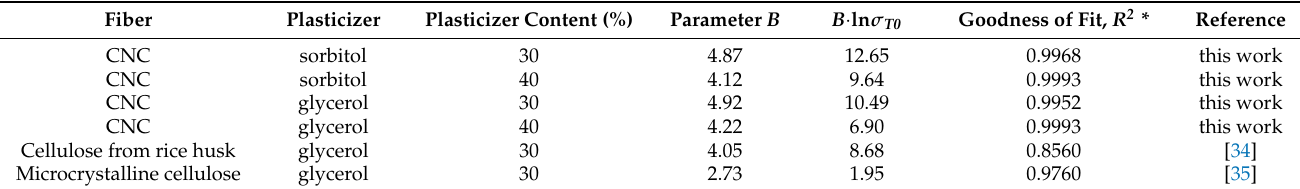
Table 2. Reinforcement in TPS–cellulose